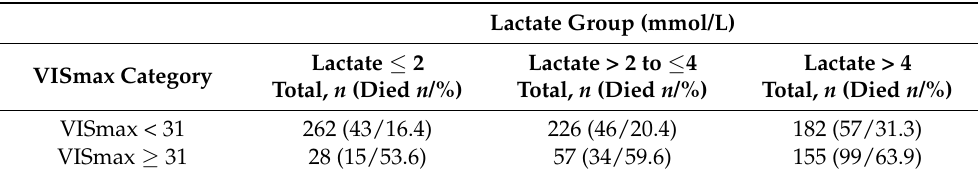
We performed subgroup analysis including only septic shock patients ( n = 410). We performed ROC curves analysis with VISmax, the APACHE II score, the SOFA score, the cardiovascular component of SOFA score, and initial lactate levels to predict 30-day mortal- ity. We performed pairwise comparisons between the variables. The discrimination power of VISmax for 30-day mortality was comparable to that of the SOFA score (AUC = 0.703; 95% CI: 0.655–0.748 vs. AUC = 0.702; 95% CI: 0.654–0.747; p = 0.974). The discrimination power of VISmax for 30-day mortality was comparable to that of the APACHE II score (AUC = 0.675; 95% CI: 0.627–0.721; p = 0.420). VISmax had better discrimination power for 30-day mortality than the cardiovascular component of the SOFA score (AUC = 0.532; 95% CI: 0.483–0.582; p < 0.001) and initial lactate levels (AUC = 0.630; 95% CI: 0.581–0.677; p = 0.019). The optimal cut-off value of VISmax to predict 30-day mortality was 27 (sensi- tivity: 67.7%, specificity: 65.2%) in patients with septic shock. In addition, we